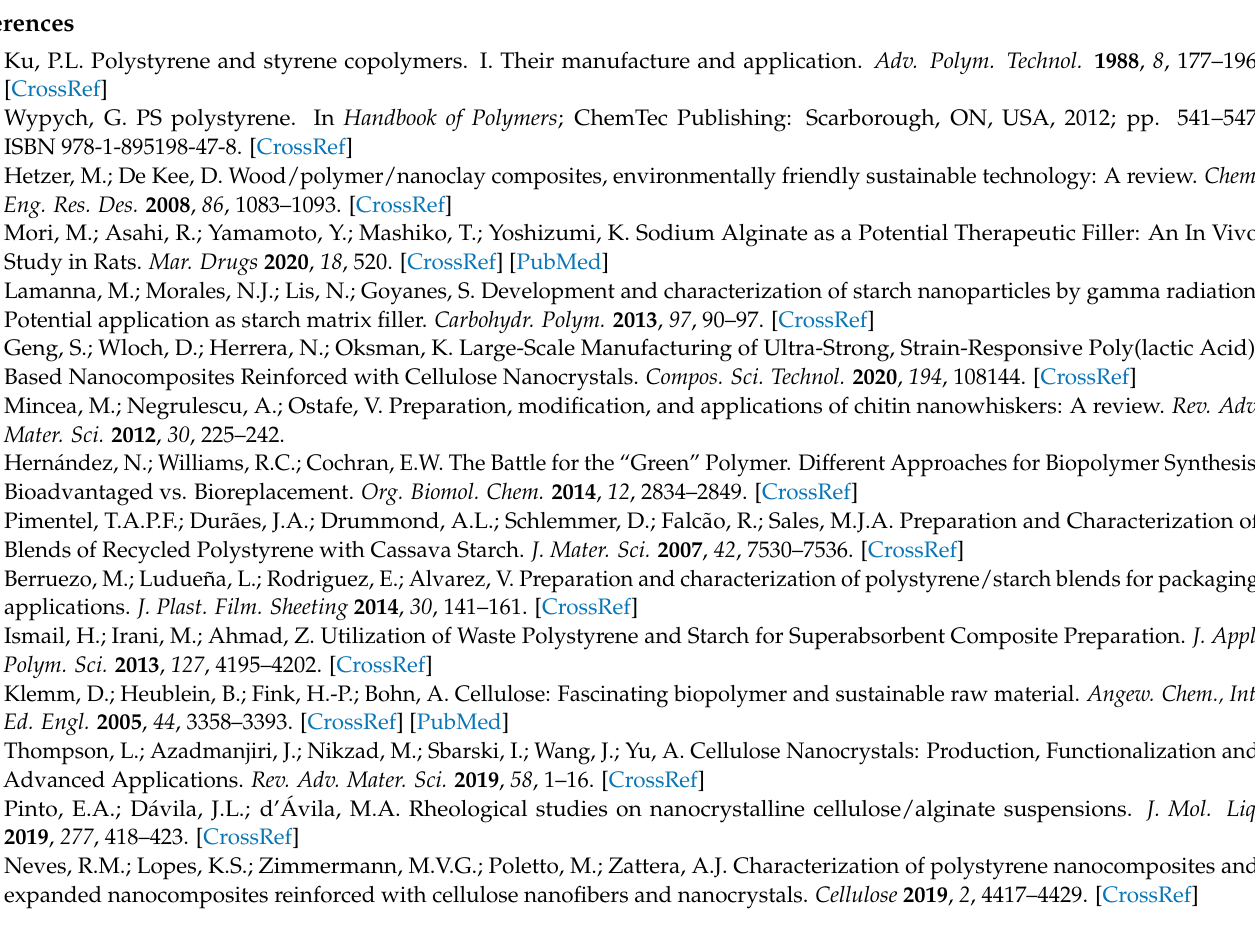
flow rate marker. Figure S3. FT-IR spectra of PSt-VBzGG-3 1 wt% SIPN (A) and PSt- l -VBzGG-3 1 wt% conetwork (B). Figure S4. Size-exclusion chromatography dRI traces of PSt isolated after 48 h of CHCl 3 extraction of VBzGG-3 copolymerization mixtures. A—1 wt%; B—5 wt%, C—10 wt%. Tol—toluene flow rate marker. Figure S5. TGA thermograms of Gellan Gum (GG), extracted poly(styrene), PSt and PSt-VBzGG-m SIPNs (PSt-GG-m). Figure S6. DSC thermograms of PSt-VBzGG-5 1 wt% SIPN (A), PSt extracted from PSt-VBzGG-5 1 wt% SIPN (B) and PSt- l -VBzGG-5 1 wt% (C). Figure S7. Stor- age modulus of PSt-VBzGG-m SIPNs (GG-1–GG-10), PSt extracted from PSt-VBzGG-m SIPNs, and poly(styrene)/Gellan Gum physical mixture (PSt/GG). Figure S8. Loss modulus of PSt-VBzGG-m SIPNs (GG-1–GG-10), PSt extracted from PSt-VBzGG-m SIPNs, and poly(styrene)/Gellan Gum phys- ical mixture (PSt/GG). Figure S9. Tan δ curves of PSt-GG-m SIPNs, PSt extracted from PSt-VBzGG-m SIPNs (GG-1–GG-10), and poly(styrene)/Gellan Gum physical mixture (PSt/GG). Figure S10. SEM of a PSt- l -VBzGG-5 10 wt% gel swollen in water. (a) sample at 200 × magnification; (b) orange-framed area in image (a) observed at 850 × magnification. Figure S11. Chemical structures of Auramine O (AO) and Bromphenol Blue